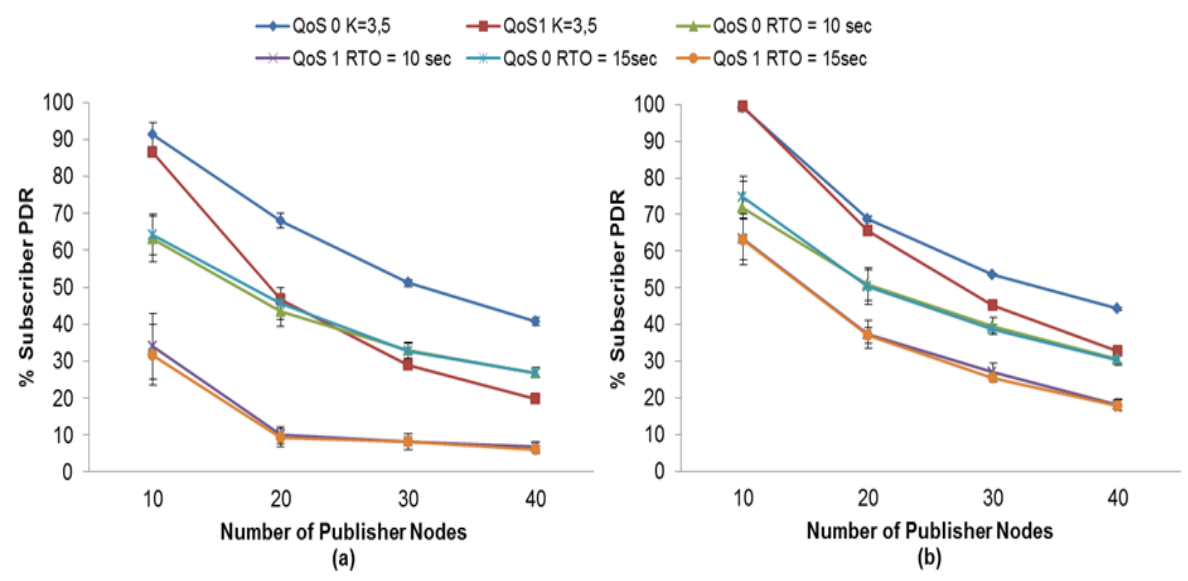
Figure 20. PDR comparisons between the RTO method of MQTT-S calculation and our proposal without ( a ) and with ( b ) MAC